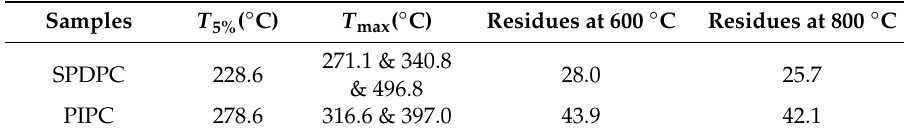
Table 1. The thermal analysis data for SPDPC and PIPC.